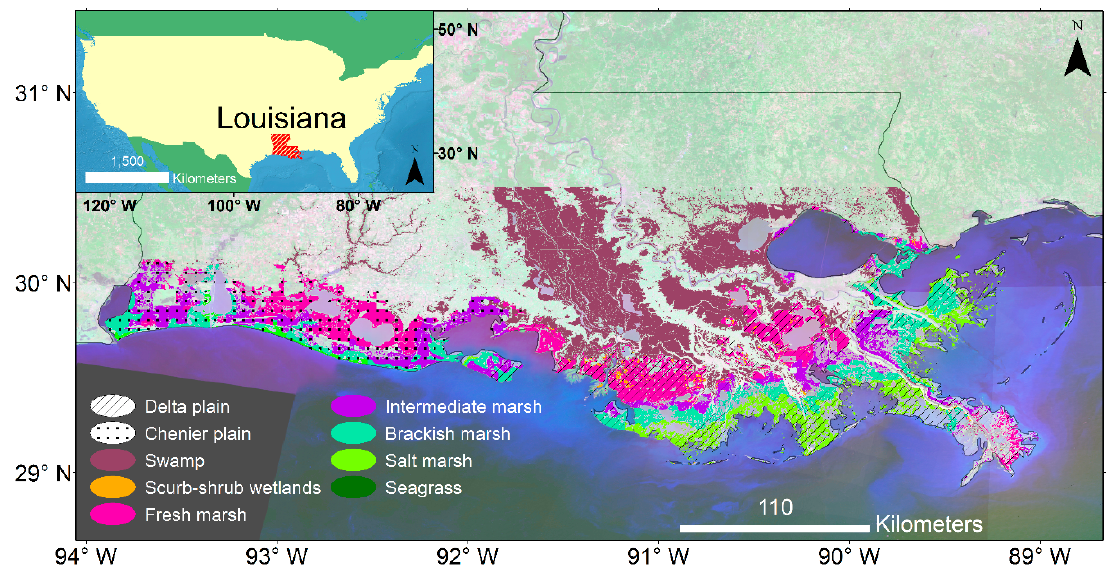
Figure 1. Location map and wetland classification generated using Gulf-Wide Information System (G-WIS) [19], Landsat mosaic [20] as background and Natural Earth data used for the location map. The wetlands with dot pattern correspond to the Chenier Plain and the hatch pattern to the Mississippi River Delta plain.